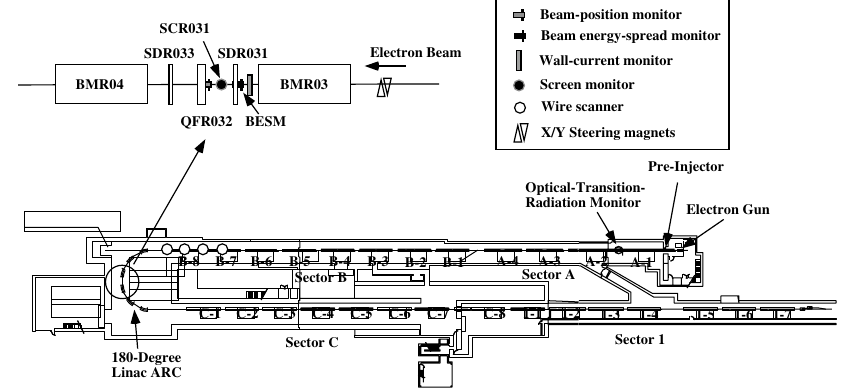
FIG. 3. Schematic layout of the beam line up to sector 1 and the experimental setup.